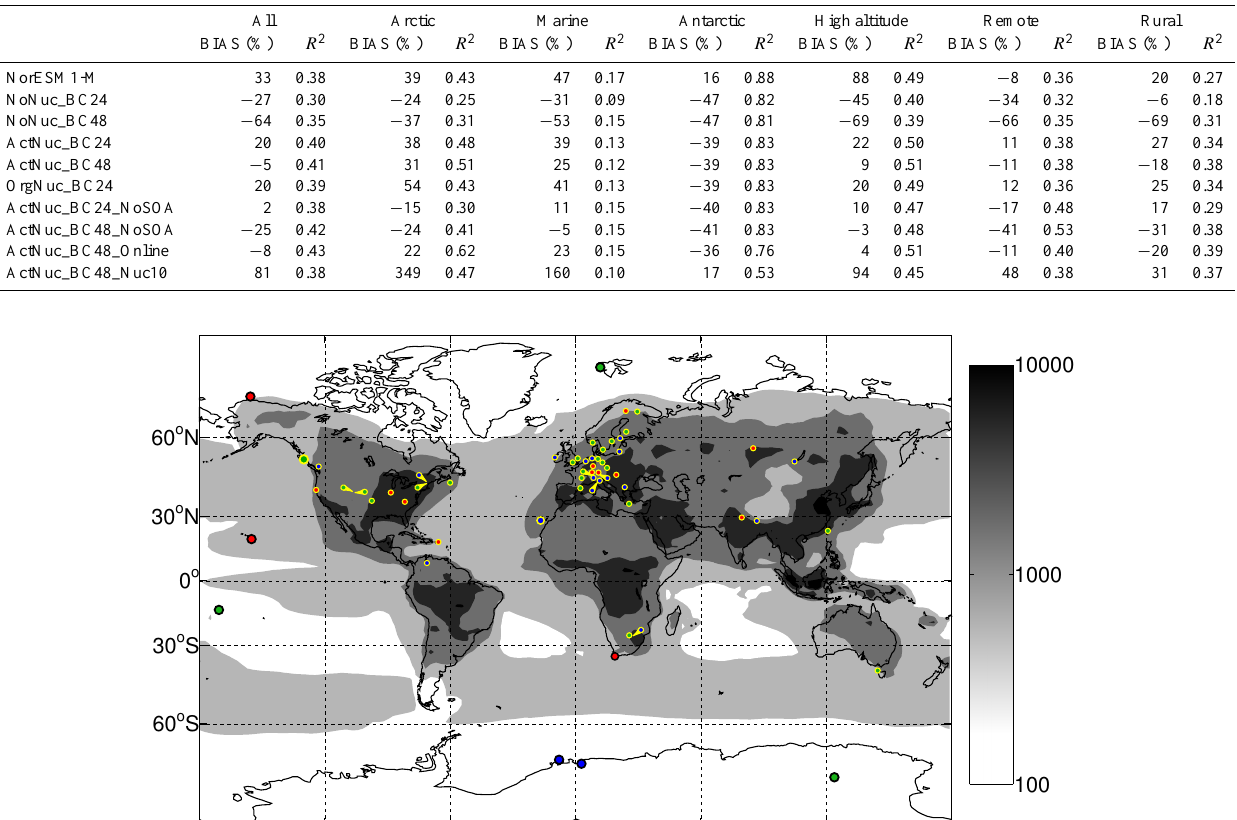
Figure 3. Locations of the sites used in this study coloured based on median number bias calculated from ActNuc_BC48. Red (blue) indicates a positive (negative) number bias higher than 20%, while green shows stations with low bias ( < 20%). The background contour shows number concentrations (cm − 3 ) from ActNuc_BC48 simulation. Size and outline colour of selected markers is adjusted for